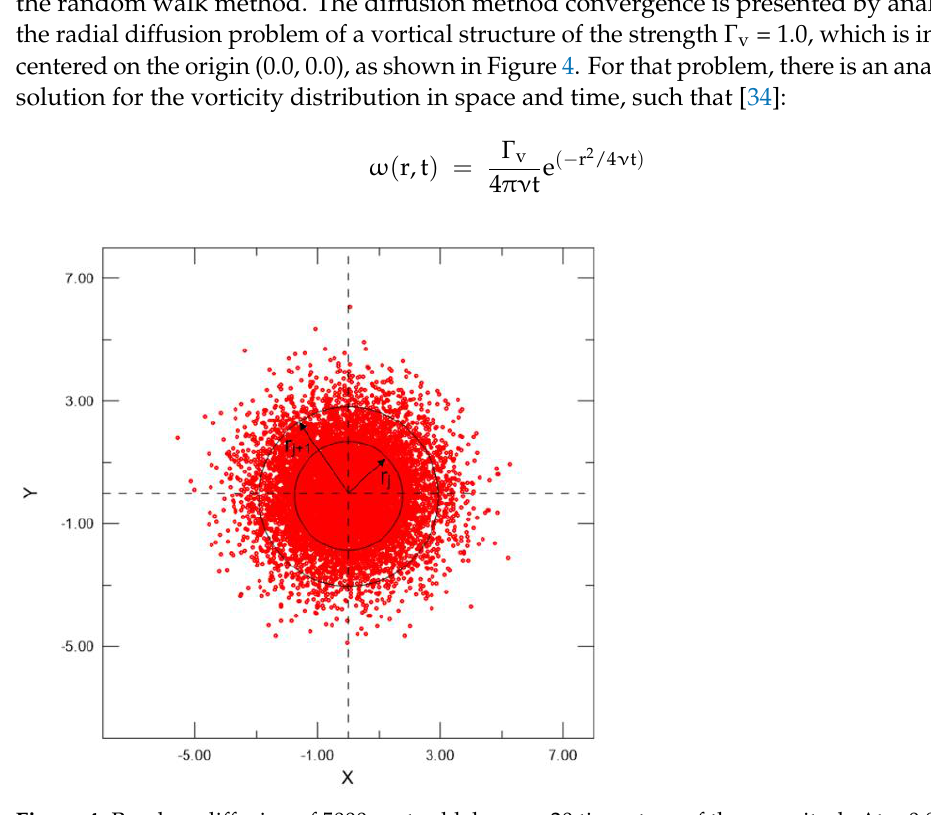
Figure 4. Random diffusion of 5000 vortex blobs over 20 time steps of the magnitude ∆ t = 0.05. Figure 5 exemplifies the test case for t = 1.0, v = 1.0, and Re = v / ν = 1 .0. For purposes